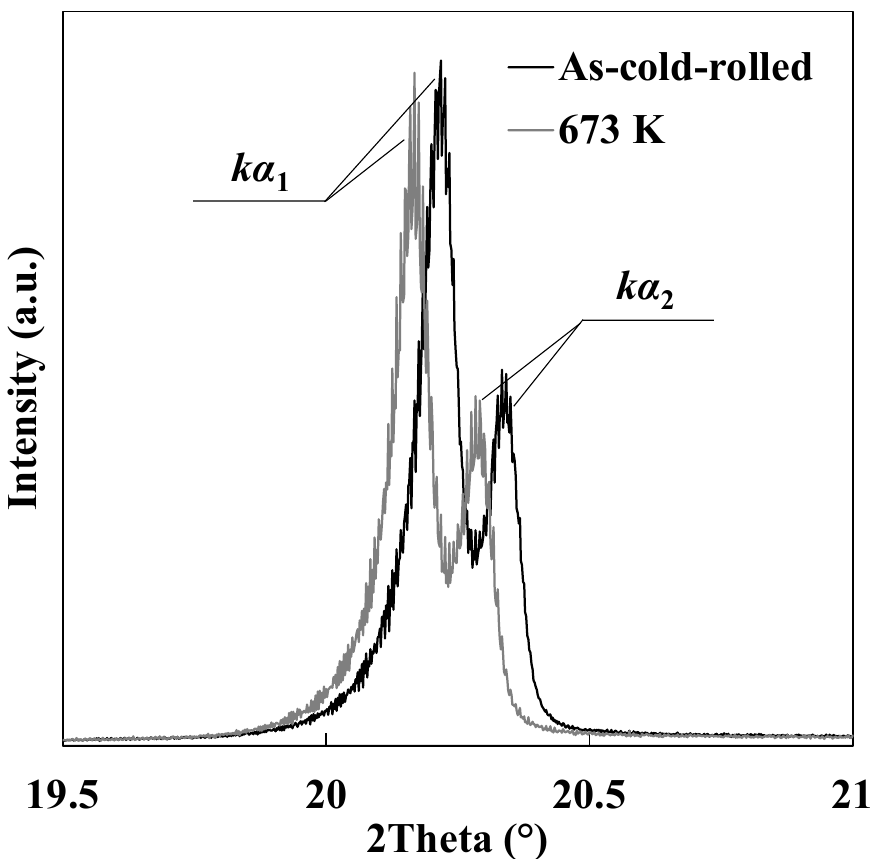
Figure 4. Typical X-ray diffraction patterns of cold-rolled and annealed specimens (crystal plane: {110}).